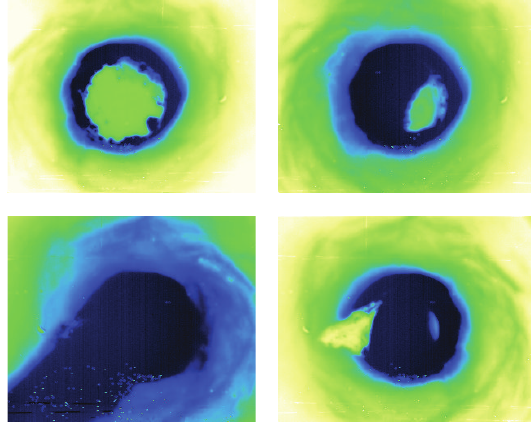
Figure 11: Combined experiment.